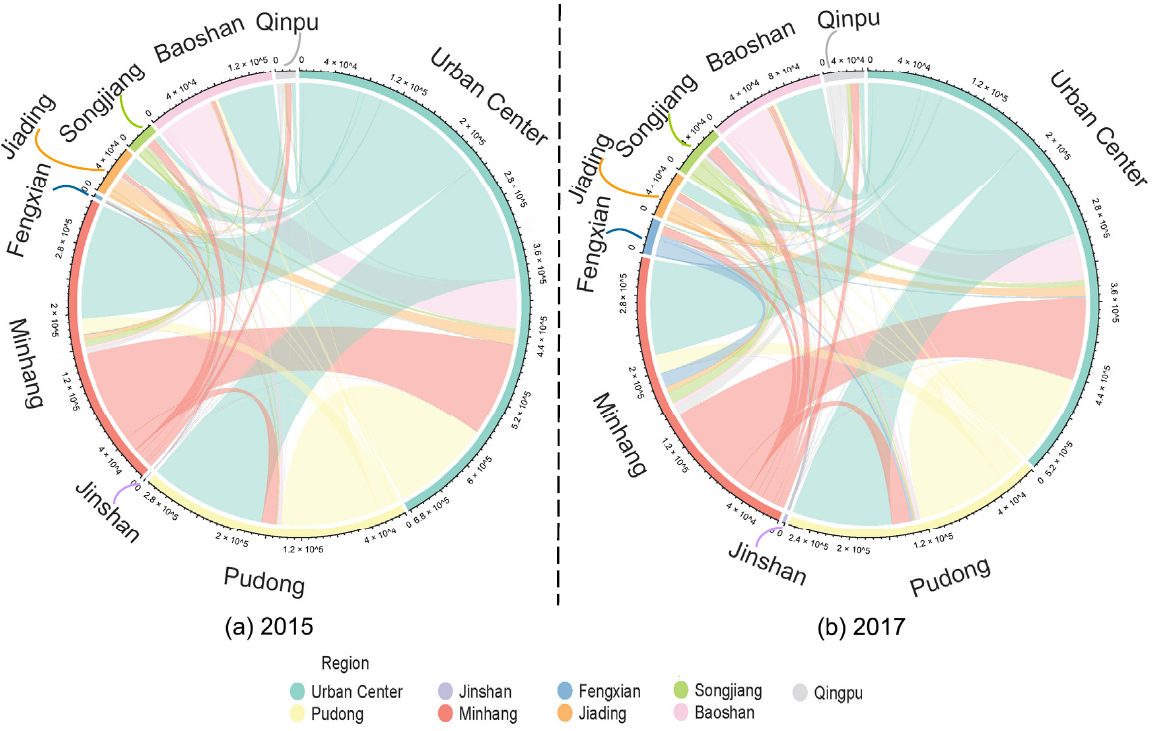
Figure 11. Traffic flow in ( a ) 2015 and ( b ) 2017.